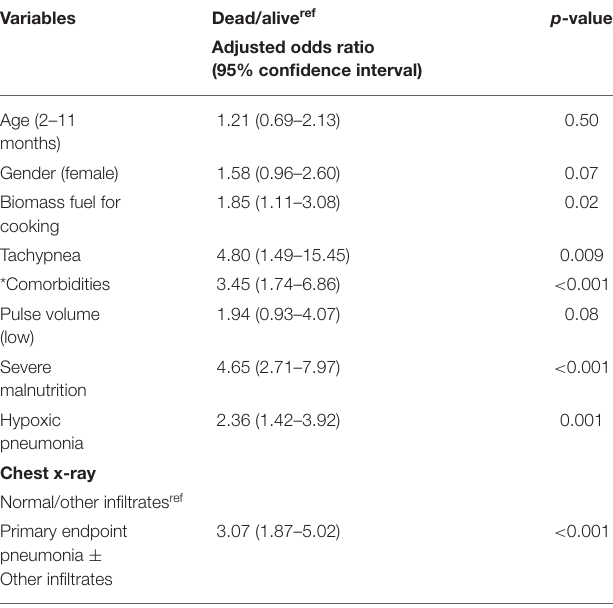
TABLE 4 | Conditional logistics regression to assess association of mortality with hypoxic CAP controlling for sociodemographic, clinical, and radiological variables.